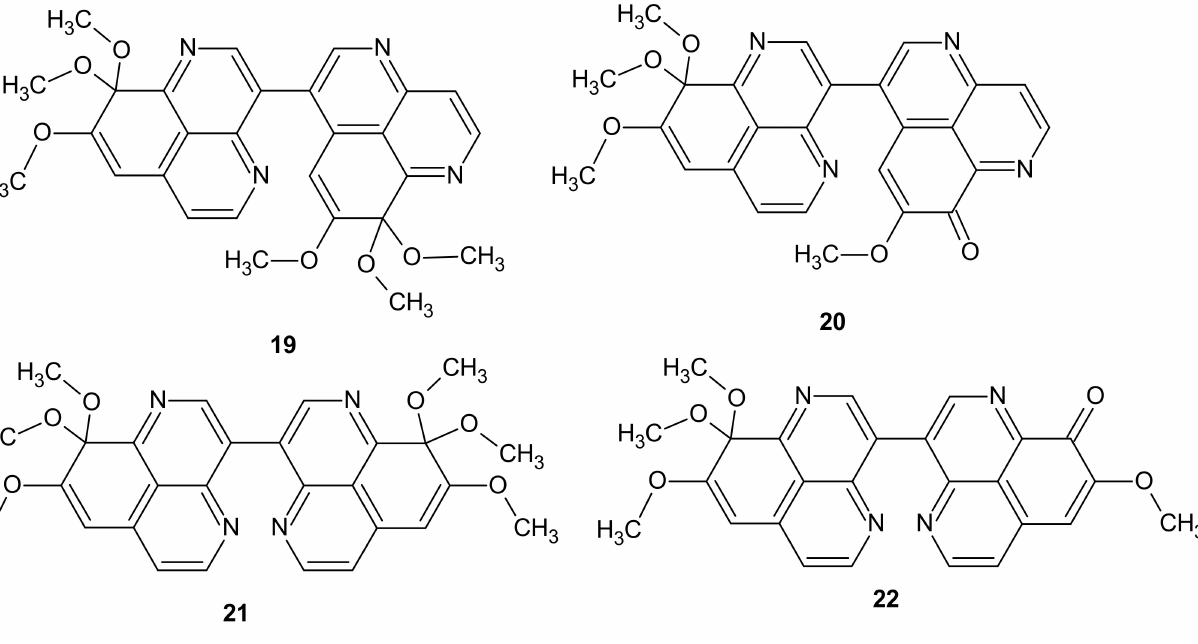
Figure 6. Structures of suberitines A-D 19 – 22 .